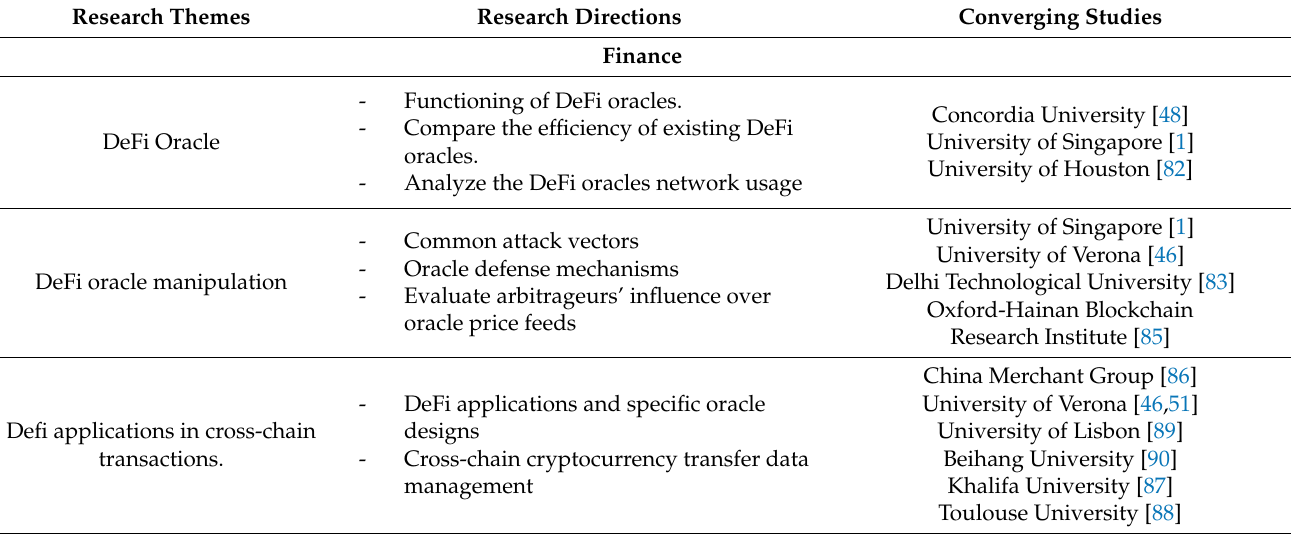
Table 13. Oracle applied: Themes, directions, and converging